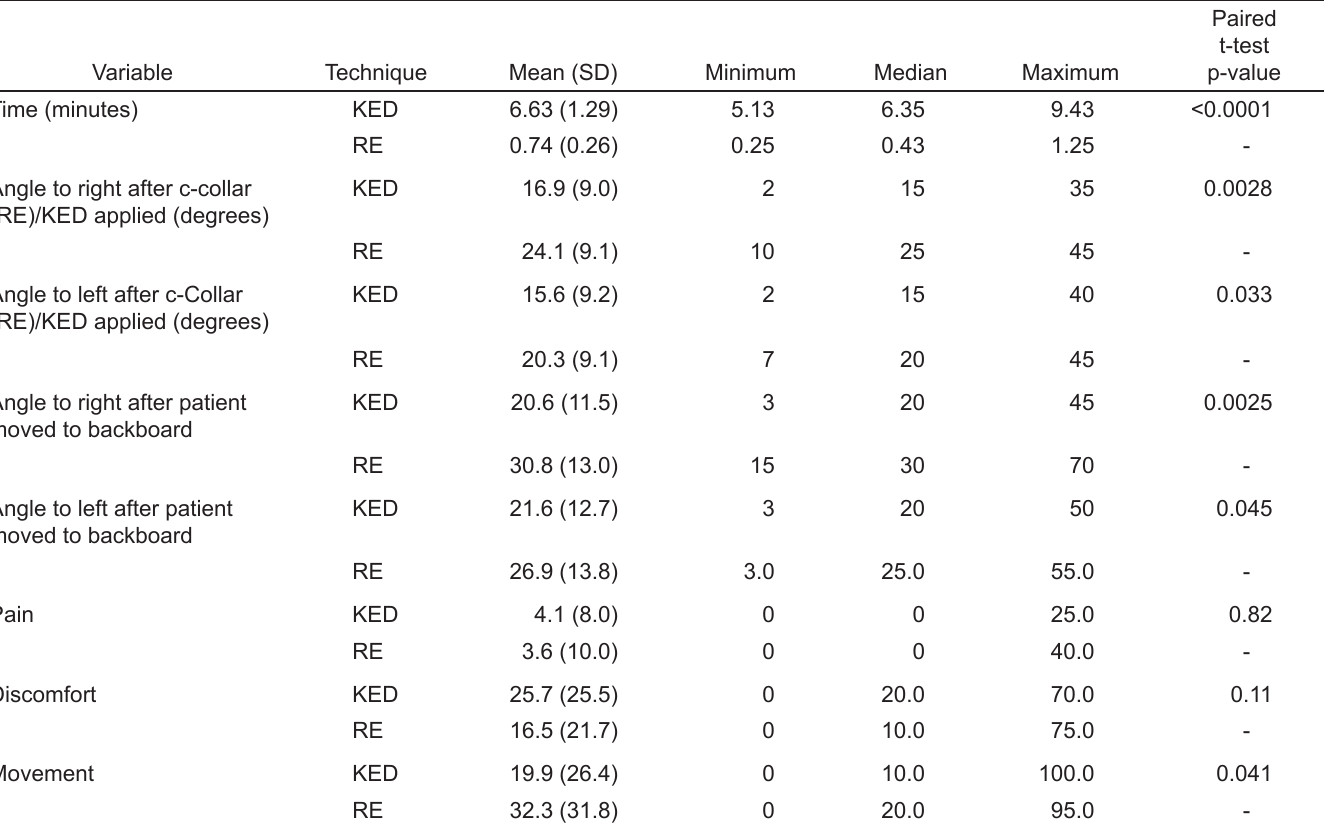
Table 1. Summary statistics for outcome variables using the KED versus RE on 23 subjects, as well as p-value for detecting a difference based on a paired